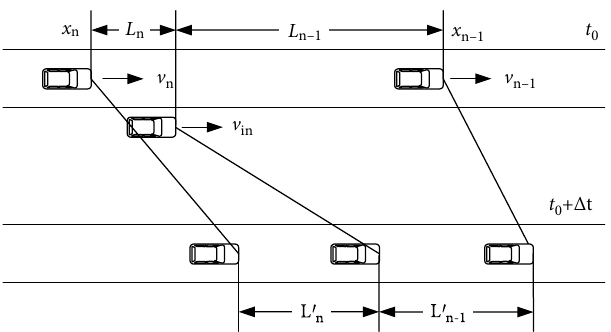
Figure 3: Schematic diagram of Lane-changing